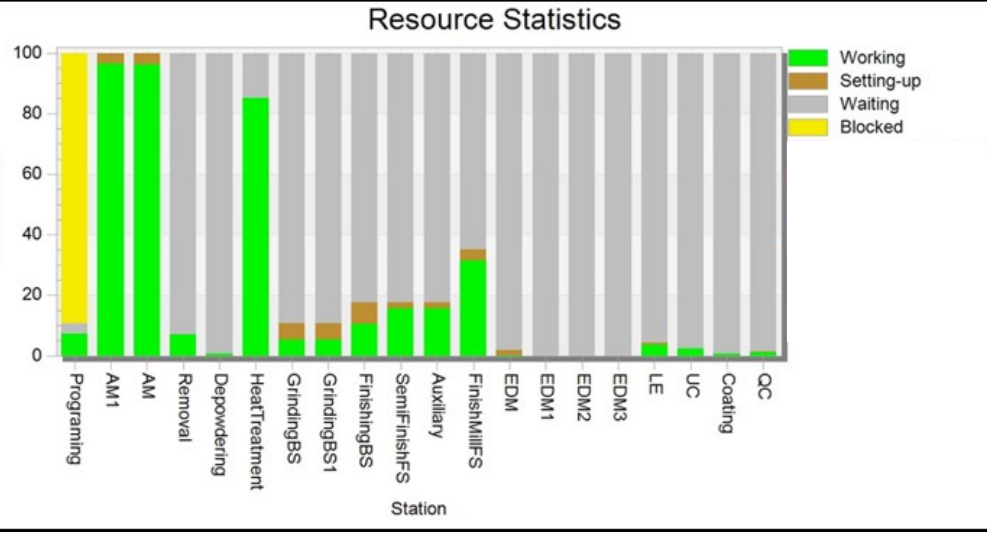
Figure 8. Resource statistics simulation for the AM workflow. The number of inserts produced in one year is 210.